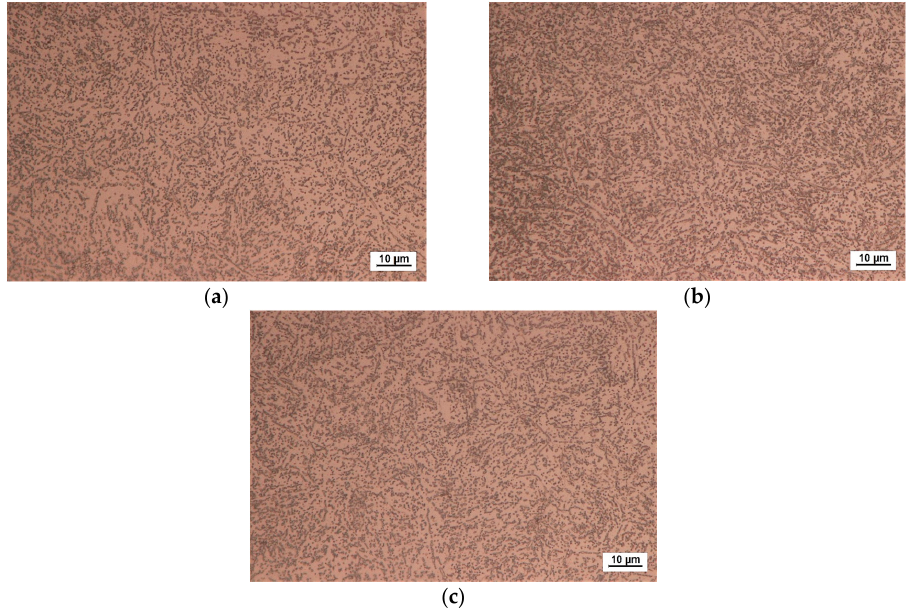
Figure 13. Optical micrograph: steel X46Cr13 (cross-section of the specimen), Aqua regia, 1000×. ( a ) As-received material; ( b ) after the creep process performed at 400 °C, 153 MPa, 1200 min; ( c ) after the creep process performed at 500 °C, 97 MPa, 1200 min.